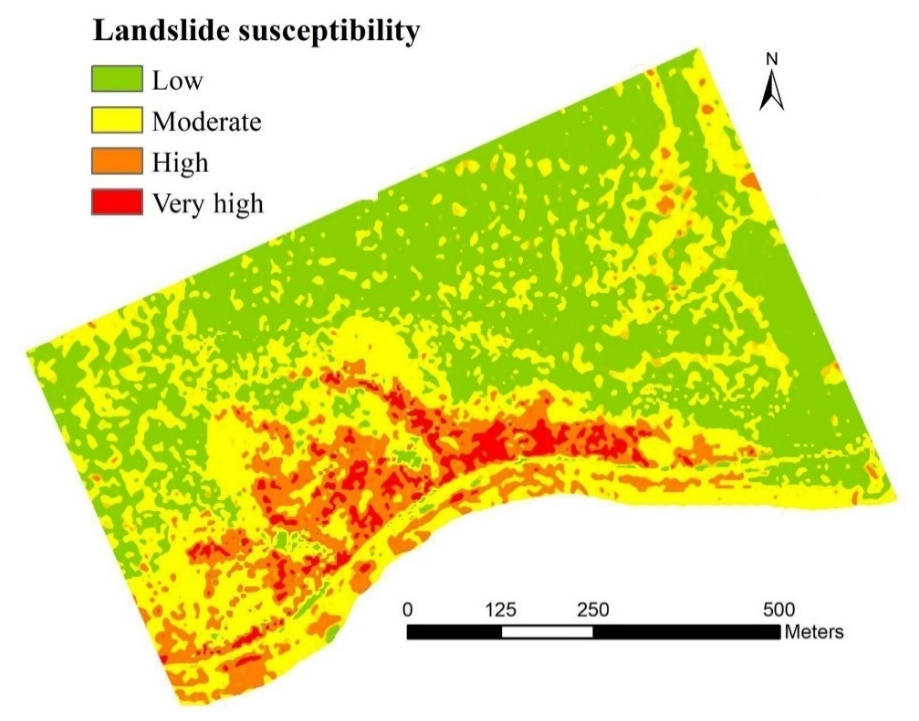
Figure 9. Landslide susceptibility map.